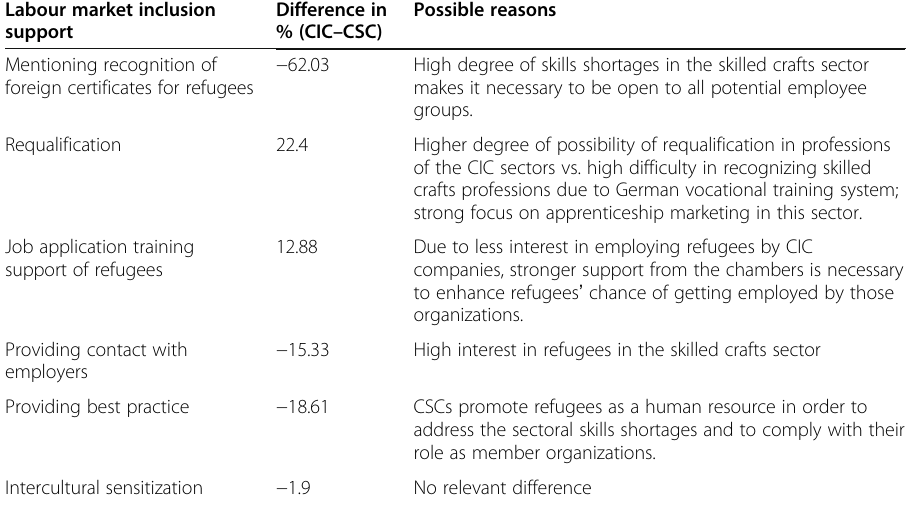
Table 1 Explanation of the differences between CSC and CIC measures Labour market inclusion support